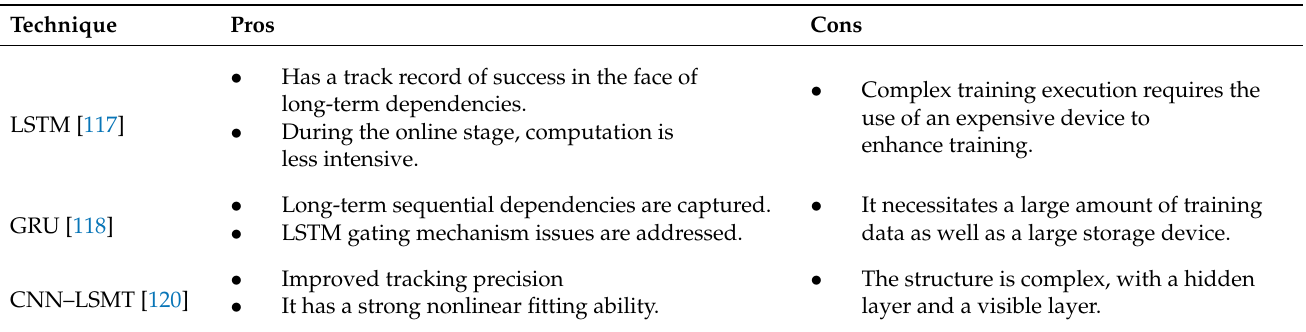
Table 9. Analysis of the different deep learning SOC estimation